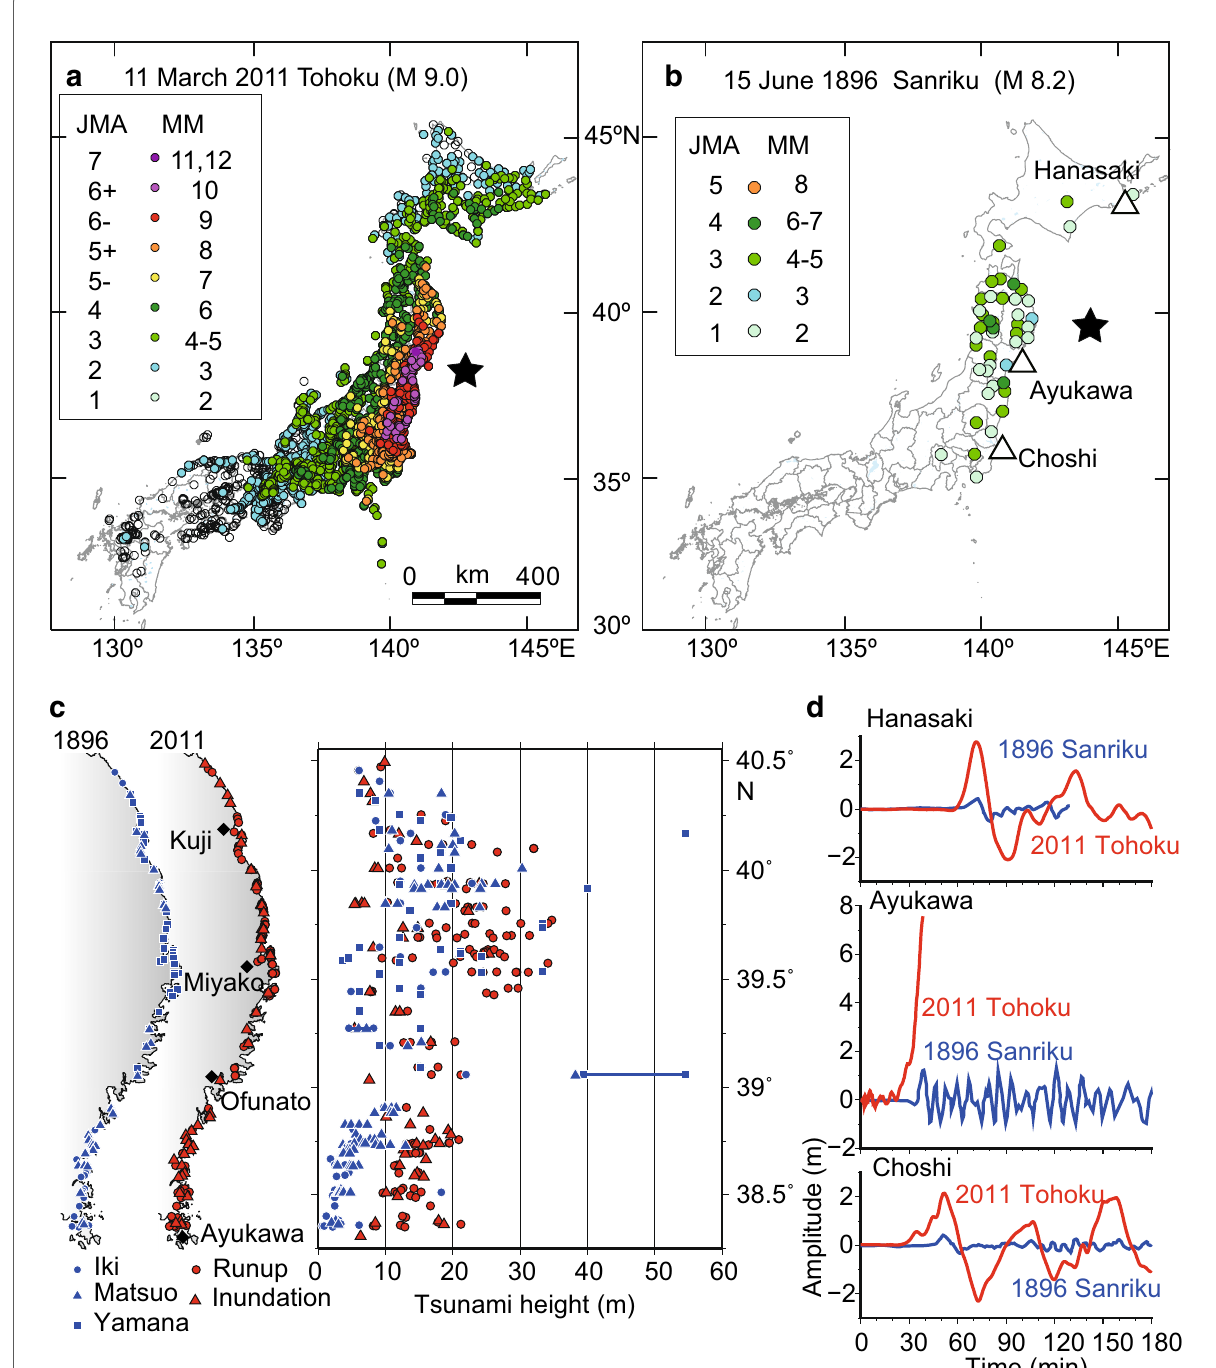
Fig. 1 a Epicenter (black star) and seismic intensity distribution of the 2011 Tohoku earthquake, according to Japan Meteorological Agency. b Epi- center and seismic intensity distribution of the 1896 Sanriku earthquake. Locations of tide gage stations (open triangles) are also shown. c Tsunami heights on the Sanriku coast from the 1896 Sanriku tsunami (blue symbols with different shapes for the data source) and the 2011 Tohoku earth- quake (red symbols with different shapes for runup and inundation heights) from Tsuji et al. (2014). d Tsunami waveforms from the 1896 Sanriku (blue curves) and 2011 Tohoku (red curves) earthquakes recorded at the three tide gage